Question: From the figure, is the trend upward or downward?
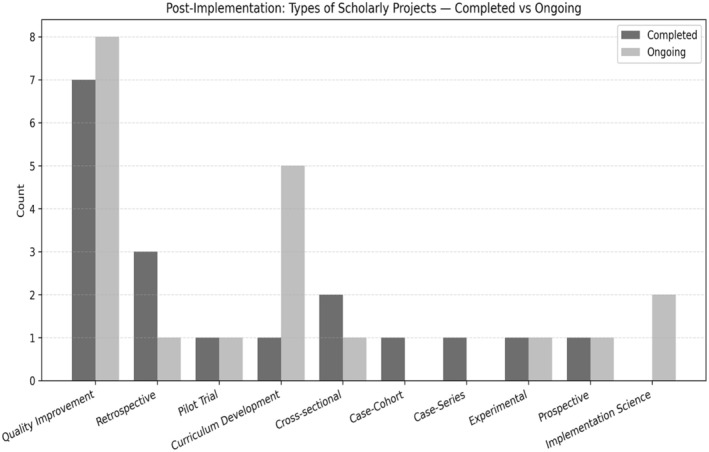
Answer: increasing